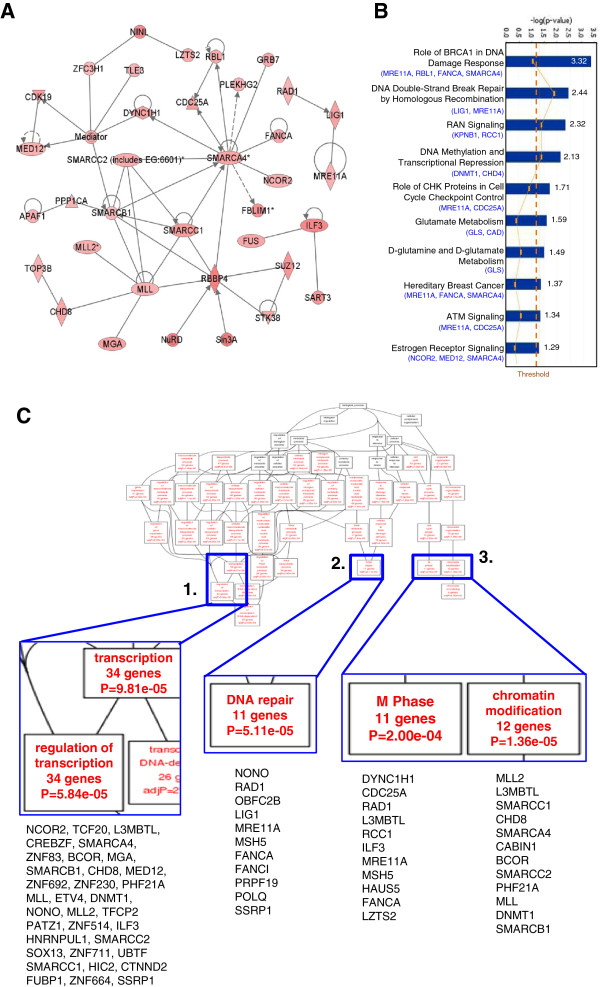
Interaction network and gene set enrichment analyses as frameworks for interpreting yHCC biology. (A) A genetic network composed of multiple yHCC genes. This network is displayed graphically as nodes (gene products) and edges (biological relationships between nodes) mapped by the Ingenuity Pathway Analysis (IPA) tool. The intensity of the node color indicates the degree of upregulation. (B) Canonical pathway analysis. Genes that are more abundant in yHCC were subjected to IPA search. (C) Altered biological modules in yHCCs. 282 probe sets that are more abundant in yHCC were subjected to Gene Ontology database search. The number of genes, gene symbols, and p values for each category that are significantly enriched are listed (p < 0.05).